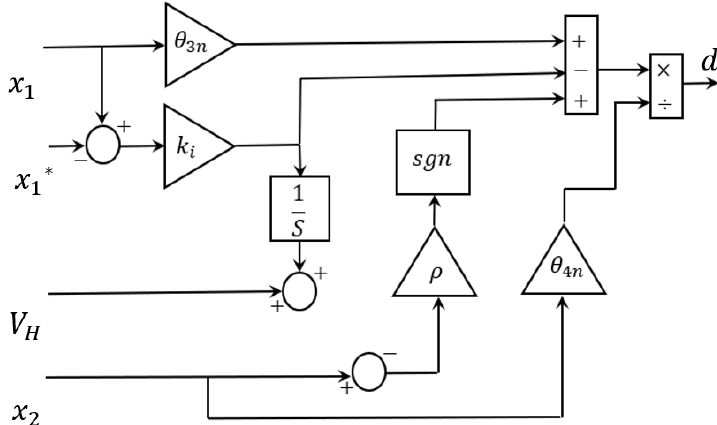
Figure 9. Block diagram of the implemented SMC regarding the Equation (41).